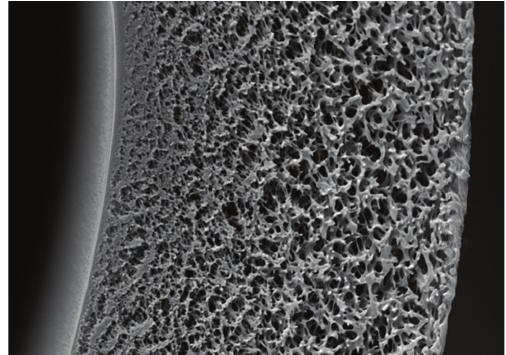
Figure 4: The scanning electron microscopy findings of cross- sectional structure of PES. The cross-section structure of PES has an asymmetric three-layer structure having a compact layer with fine pore size on the inside and outside of the hollow fiber as well as a support layer in the central part thereof.